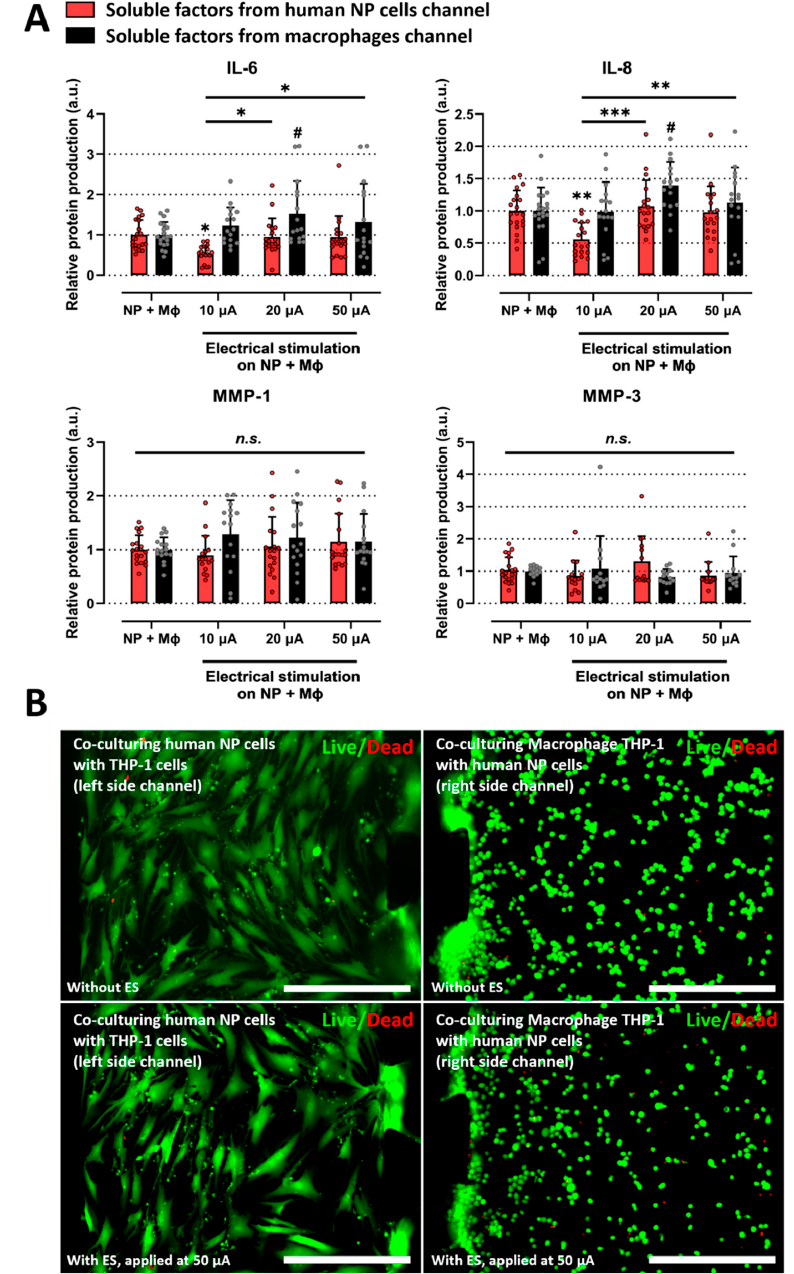
Figure 3. Effects of electrical stimulation on the microfluidic platform under coculturing conditions. ( A ) Protein production in human NP cells and macrophages with/without ES on the microfluidic platform. The ES, applied at 10 μ A, inhibits the protein production of inflammatory mediators such as IL-6 and IL-8 in degenerative human NP cells. ( B ) Assessment of human NP or macrophage cytotoxicity with/without ES applied at 50 µ A on the microfluidic platform using a live/dead assay. 50 µ A is the maximum dose used in this study. The cells did not show a difference in cell cytotoxicity (scale bar = 400 µ m). * p < 0.05, ** p < 0.01, *** p < 0.001, and n.s., no significant difference, as compared with human NP cells cocultured with macrophages. # p < 0.05 as compared with macrophages cocultured with human NP cells. The line indicates the comparison with each group. Each dot represents the mean of six samples in an independent